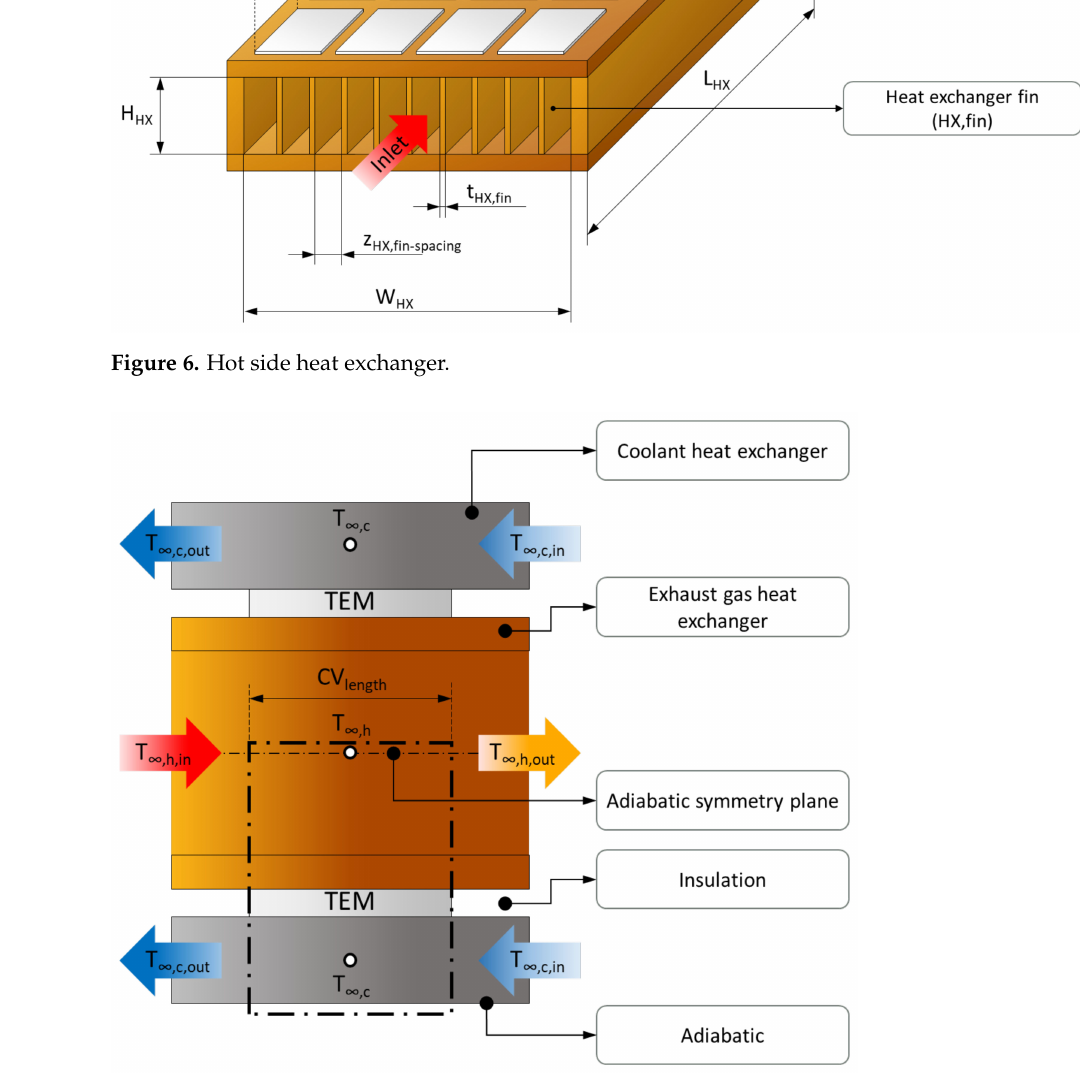
Figure 7. Side view of module